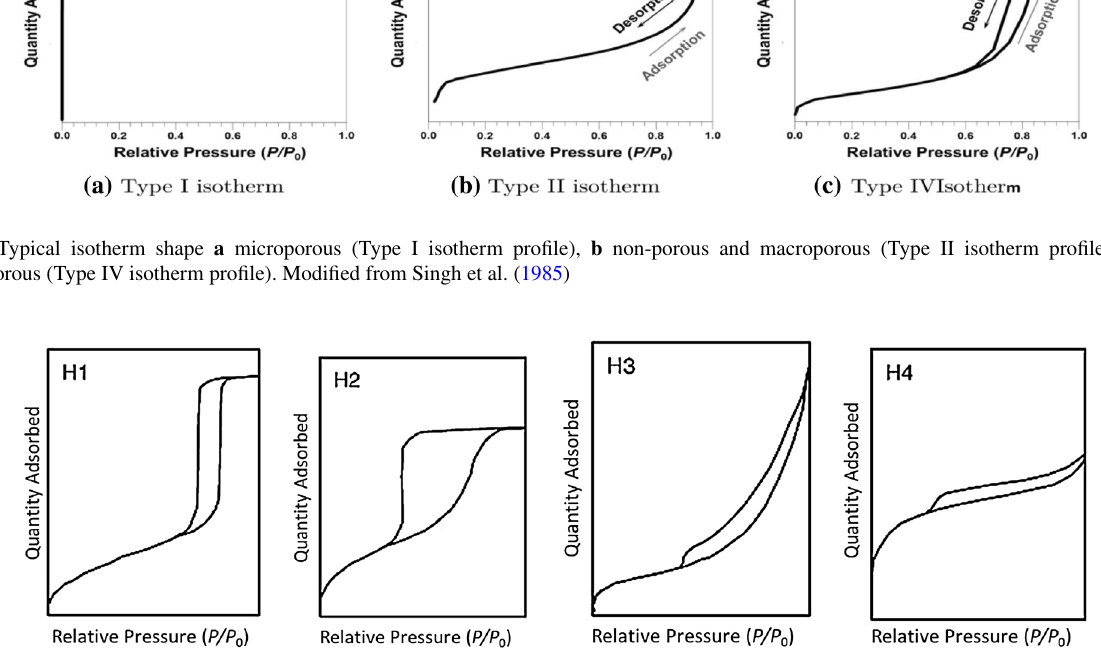
2 adsorption. Modified from Singh et al.